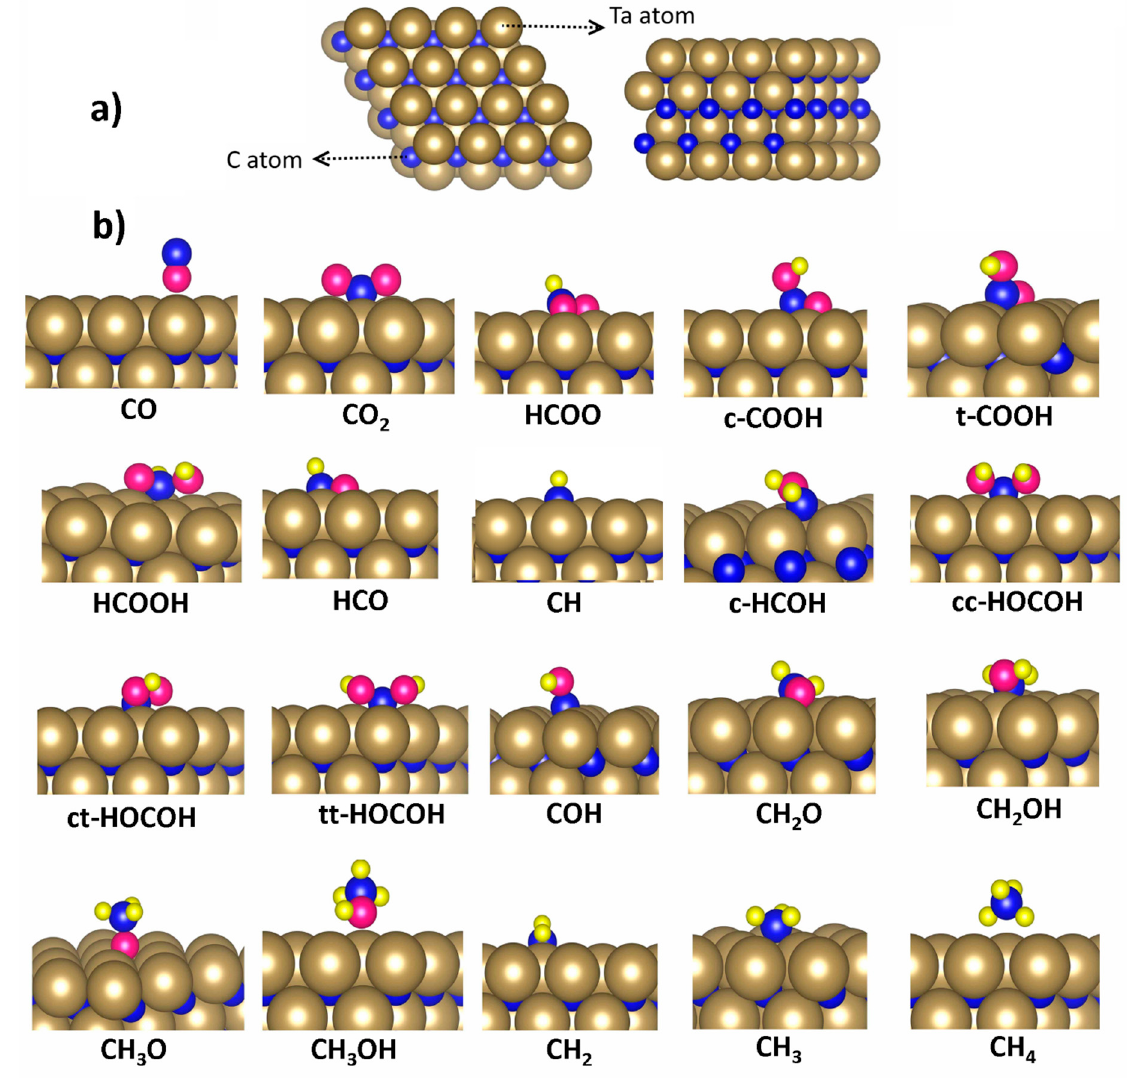
Figure 1. ( a ) TaC (111) surface, ( b ) the adsorbed geometries of the studied species during CO 2 hydrogenation on the TaC (111) surface. Carbon atoms are shown in dark blue, oxygen atoms in magenta, titanium atoms in gold, and hydrogen atoms in yellow spheres.